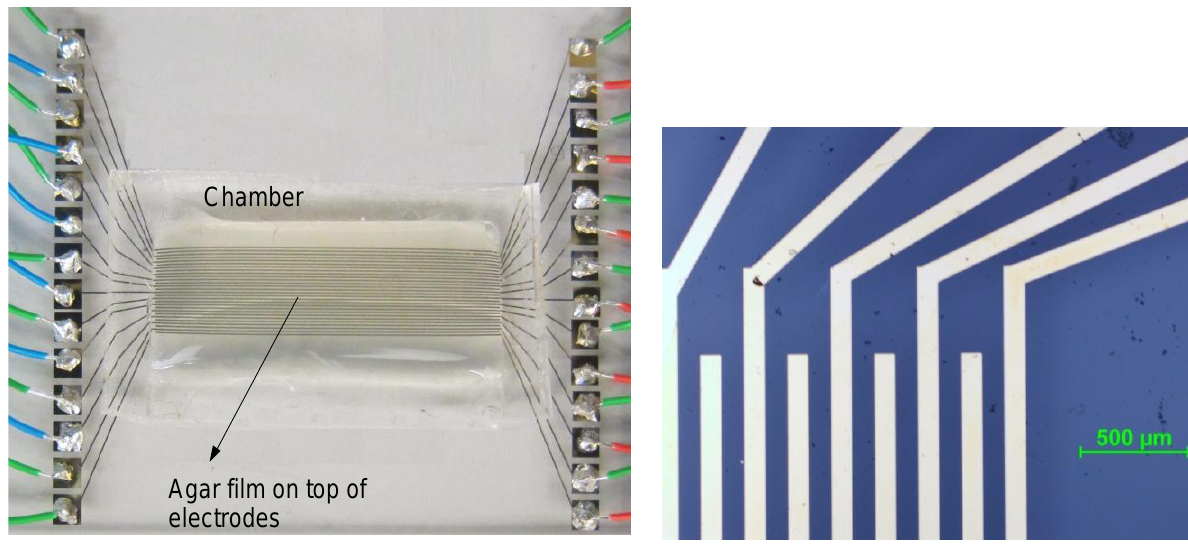
Figure 4. Biosensor chip with agar film prior to culturing ( left ) and close-up of the electrodes ( right